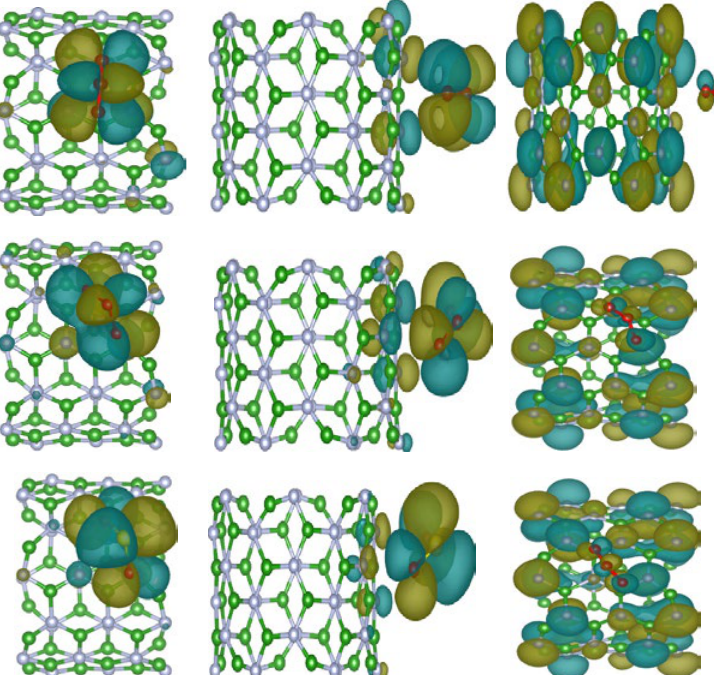
Fig. 7. Isosurface plots of HOMOs and LUMOs for O Figure 7. Isosurface plots of HOMOs and LUMOs for O 3 adsorbed BN nanotubes.